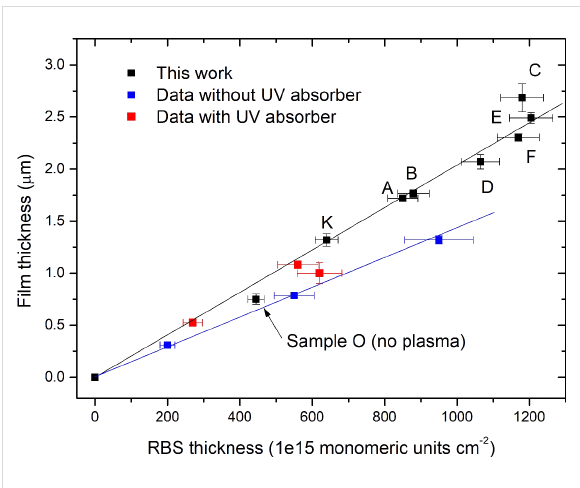
Figure 2: Film thickness versus RBS thickness (see text for details). Blue and red squares data are drawn from [56]. The two lines are guides for the